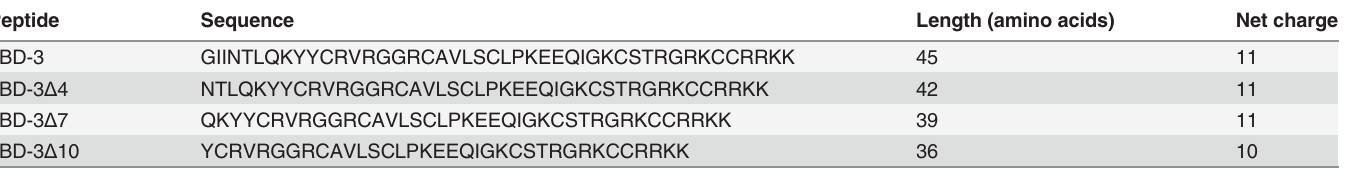
Table 1. Sequences and net charges of hBD-3, and N-terminus deletion analogs. Peptide Sequence Length (amino acids)